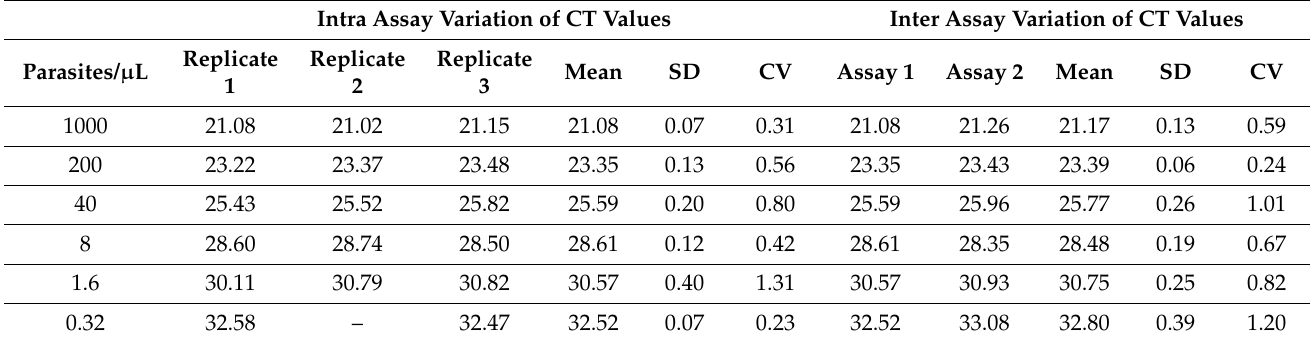
Table 3. Reproducibility and repeatability of real-time PCR assay for Pm .